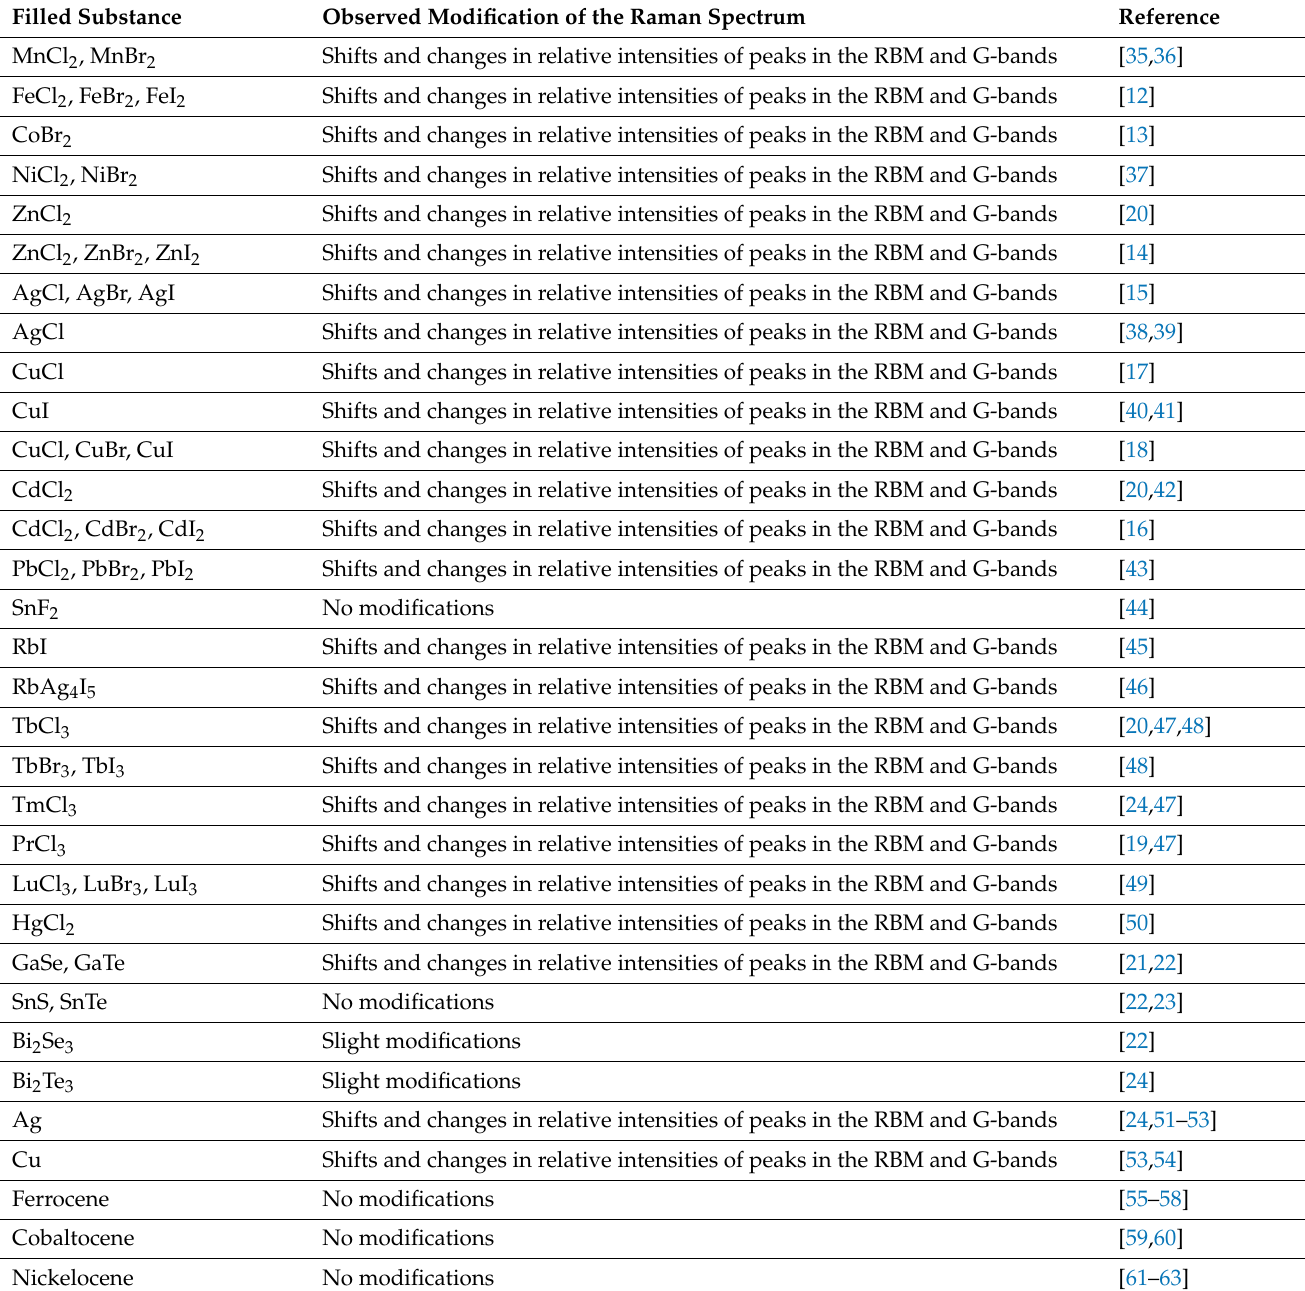
Table 2. Summary of doping-induced modifications of the Raman spectra of filled